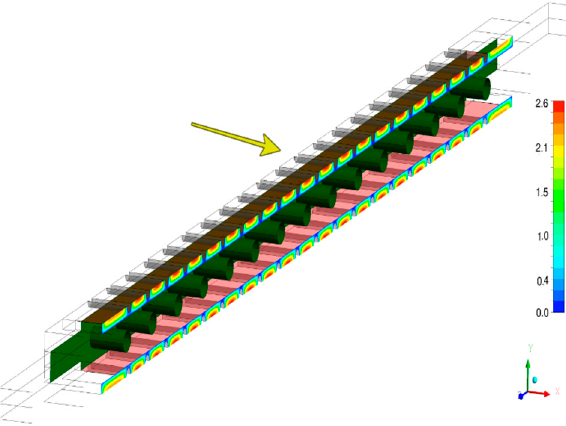
Figure 4. Airflow streamlines colored by pressure [Pa] through an air channel (arrow shows the airflow direction).